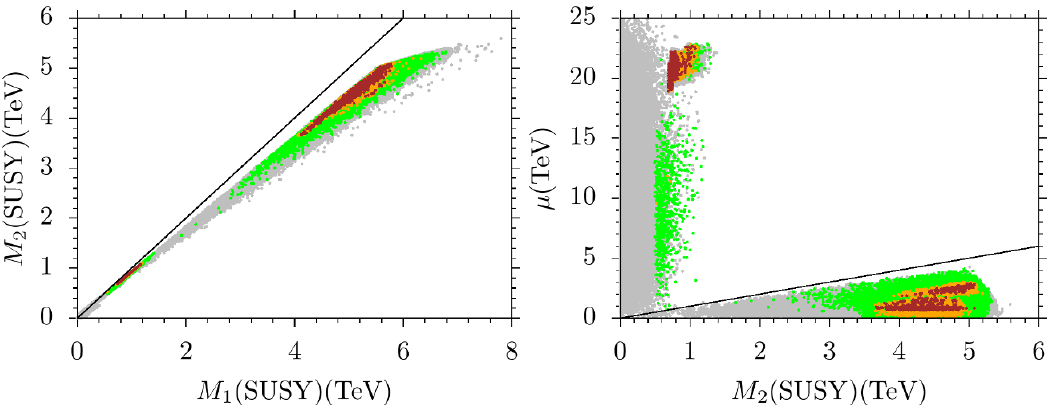
Figure 8 . Plots in the M 2 (cid:0) M 1 and (cid:22) (cid:0) M 2 planes. The color coding is the same as in (cid:12)gure 4. The black lines indicate the regions where the plotted parameters are equal to each other. rent constraints from the direct detection experiments. We show our results for the spin- independent (left) and spin-dependent (right) scattering cross-sections as a function of the LSP neutralino mass. In the (cid:27) (cid:0) m plane, the dashed (solid) blue line represents SI ~ (cid:31) 0 1 the current (future) results from the SuperCDMS experiment [101]. The dashed (solid) line indicates the current (future) results from the LUX-Zeplin experiment [102]. In the (cid:27) (cid:0) m plane, the solid black line represents the currrent bound from Super-K [103], SD ~ (cid:31) 0 1 while the orange solid line is set by the LUX results [104]. The purple line is obtained from the collider analyses [105]. The dashed (solid) blue line shows the current (future) results from IceCube